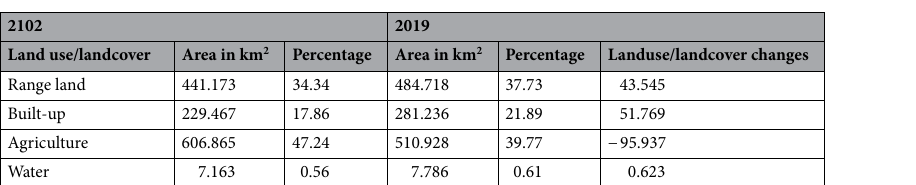
Table 4. Showing the landuse/landcover classes of district